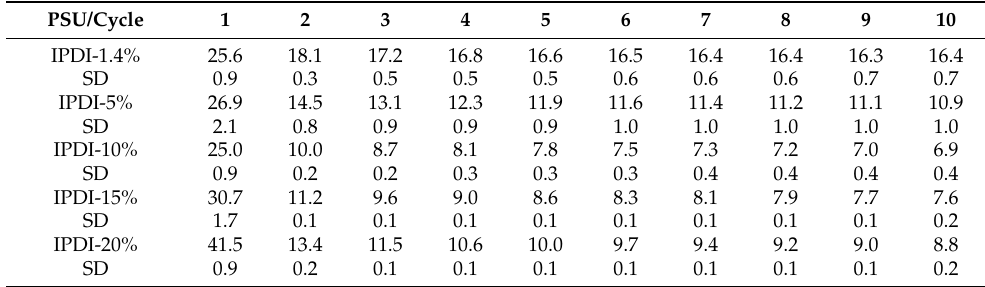
Table A6. Tensile hysteresis at 300% strain of PDMS-based polyurea elastomers synthesized from isophorone diisocyanate (IPDI) with HS contents between 1.4% and 20%. Values are given as an average of three repeated measurements. SD: standard